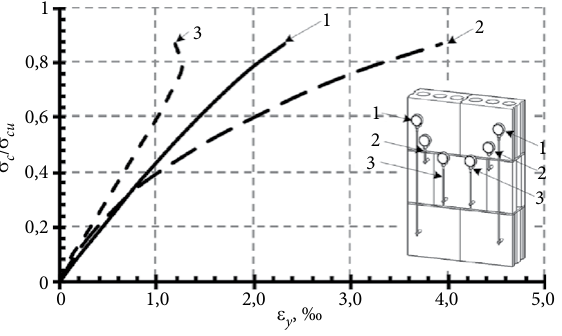
Fig. 9. Stress-strain curves of masonry (1), bed joint (2) and unit (3)